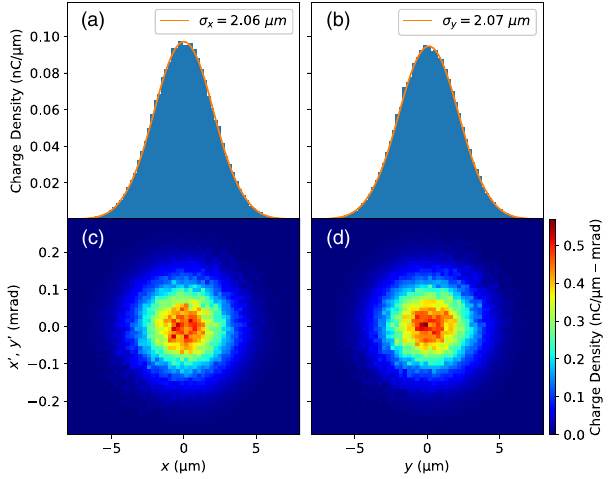
FIG. 6. Projected distribution of the horizontal (a) and vertical (b) coordinates of the electron witness beam at its waist following the passive thin plasma lens. A Gaussian fit to the profile is shown with the orange line. Transverse phase space in the horizontal (c) and vertical (d) planes exhibit perfectly Gaussian profiles in all transverse